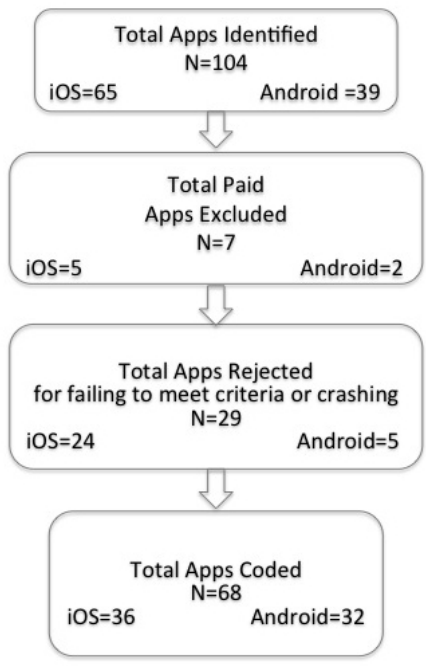
Figure 1. Android and iOS app selection flow chart.